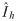
Duration of the pandemic and minimum health system capacity.(a) The normalized duration of the pandemic, Tr/T0, as a function of the variable X = T0/(τ + ρ) (Eq 29). (b) Solid curves: The minimum required health system capacity I^h to reach herd immunity (Eq 30) as a function of the duration of immunity after recovery, for different values of R0 (from 1.5 to 4.0 in steps of 0.5). Dotted curve: limit R0 → ∞. Circles represent the scenario for ρ = 93τ. Open: Ih = 0.01. Closed: Ih = 0.0025.